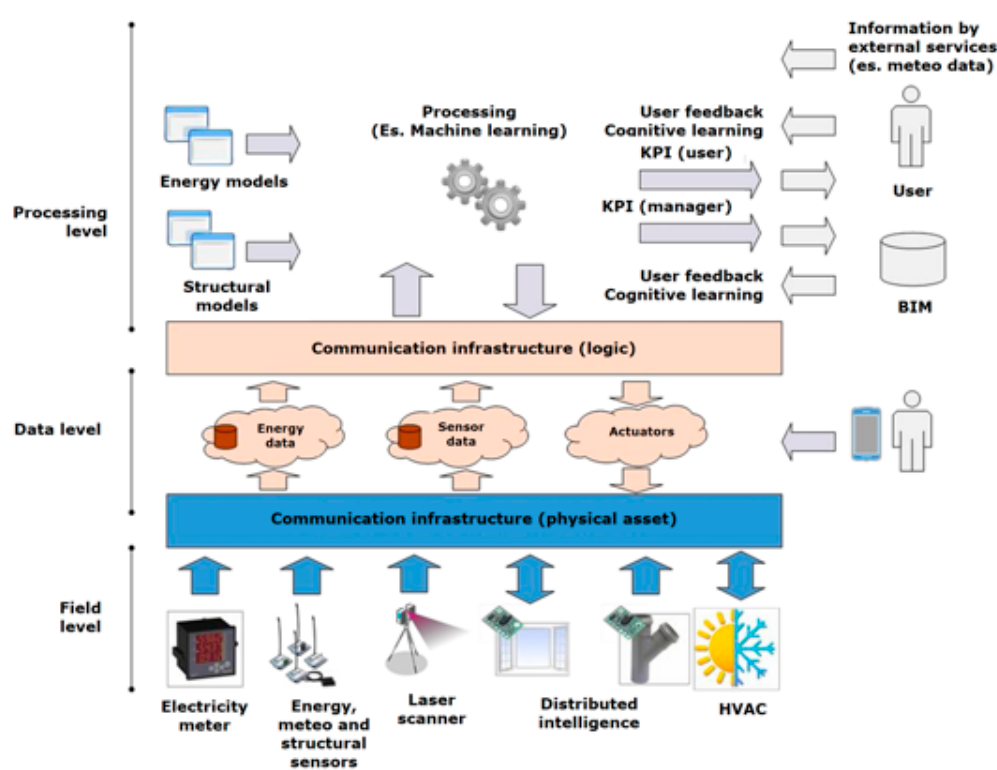
Figure 2. ELISIR organization and layers of activities.